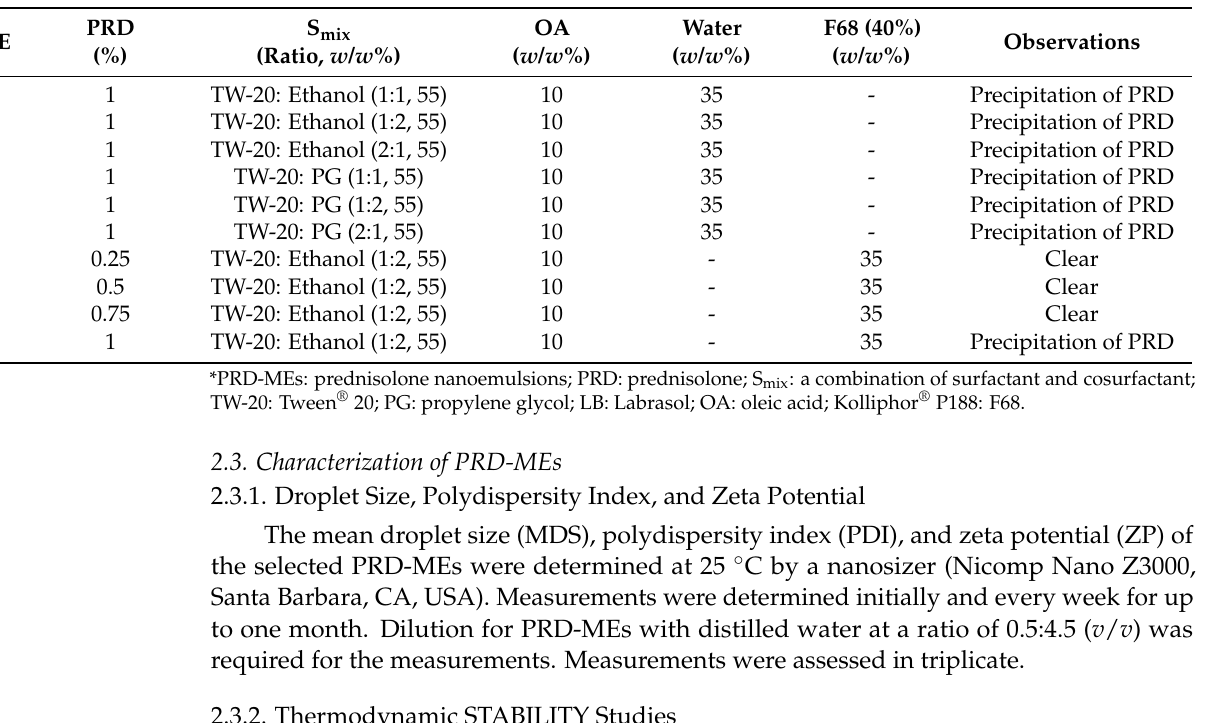
Table 2. Composition of